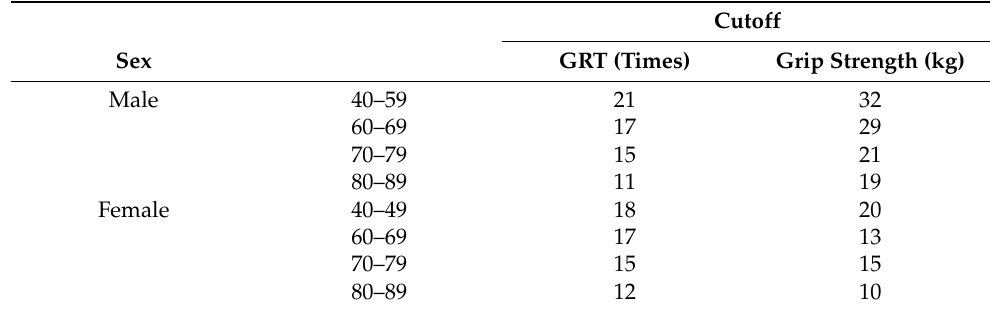
Table 3. A novel diagnostic support tool for degenerative cervical